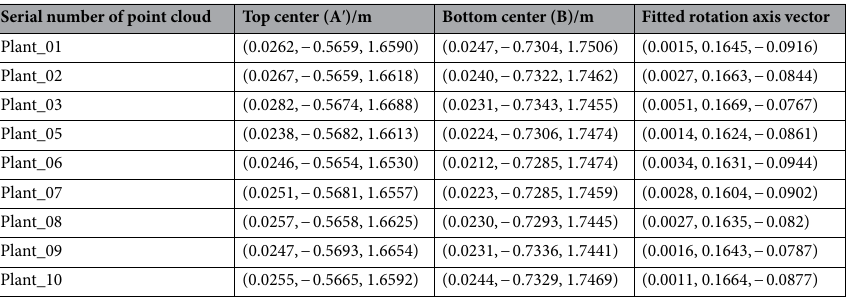
Table 3. The coordinates of the top center point and the bottom center point, the fitted rotation axis vectors.